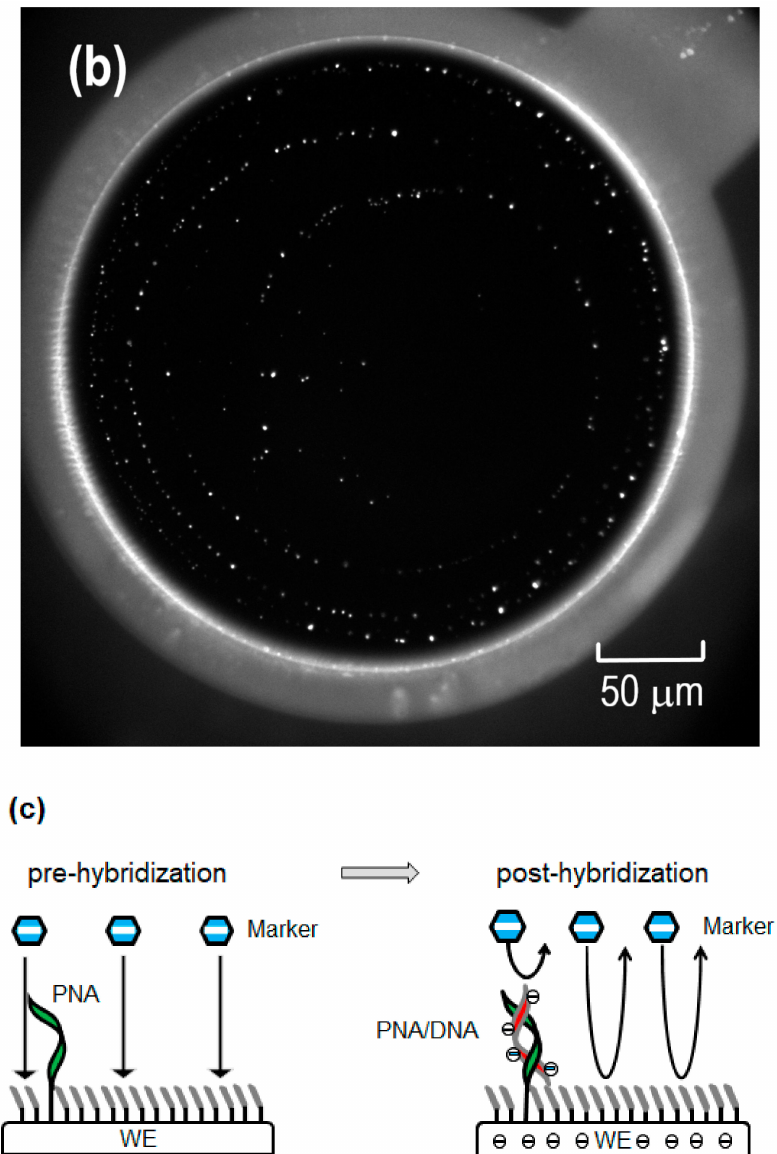
Figure 2. ( a ) Ordinary sensor working model where the PNA is uniformly distributed over the WE. Prior to hybridization, negatively charged markers can access and transfer electrons to the WE. After hybridization, electrostatic repulsion between the negatively charged marker and the uniformly distributed PNA / DNA duplexes at the WE surface hinders the redox reaction of the marker. ( b ) Fluorescence image (OLYMPUS Fluorescent Microscope; BX53M) of peptic nucleic acid (PNA)(N1) / DNA(D1) duplexes obtained after the fluorescent labeling of cDNA (carboxytetramethylrhodamine (TAMRA)). The electrode diameter was ∅ 300 µ m, and the target DNA concentration was 100 nM. The fluorescence pattern was not uniformly spread over the WE, but rather exhibited a one-dimensional swirl-like pattern. ( c ) New sensor working model wherein PNA is modified in a one-dimensional swirl-like pattern. Prior to hybridization, negatively charged markers can access and transfer electrons to the WE. After hybridization, the negative charge of the PNA / DNA duplexes imparts a negative potential to the WE through the π – π stacks and hinders the redox reaction of the marker over the entire